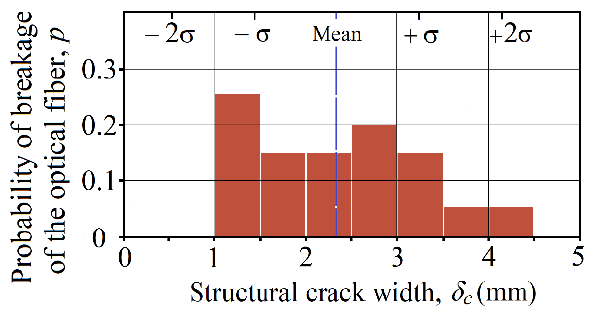
Figure 2. Probability of breakage of the optical fiber, p , as a function of structural crack width that causes the crack, δ c , obtained by performing a simple tensile test and determined for sequential intervals of a width of 0.5 mm.